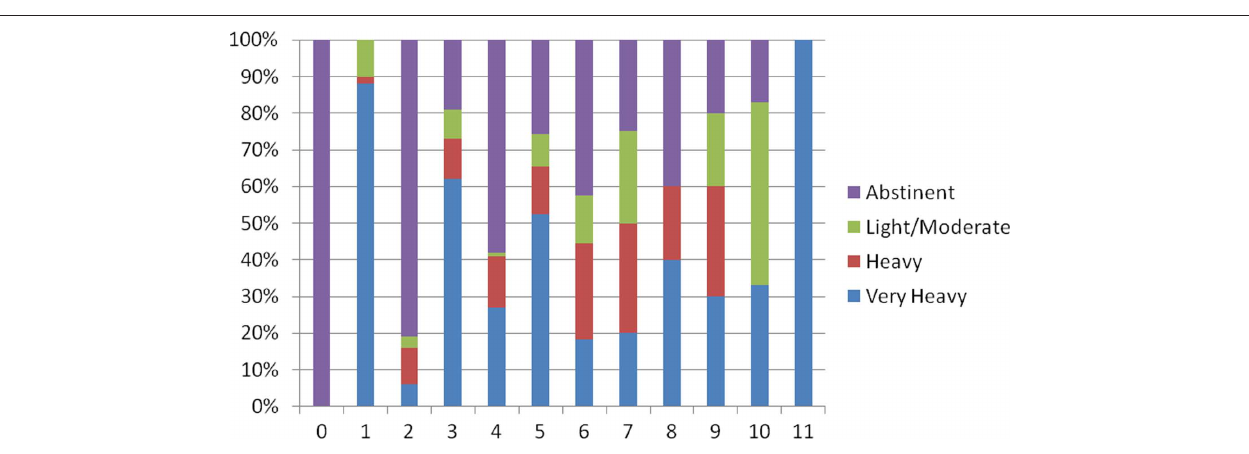
of cases ( y -axis) data and trendline. 10